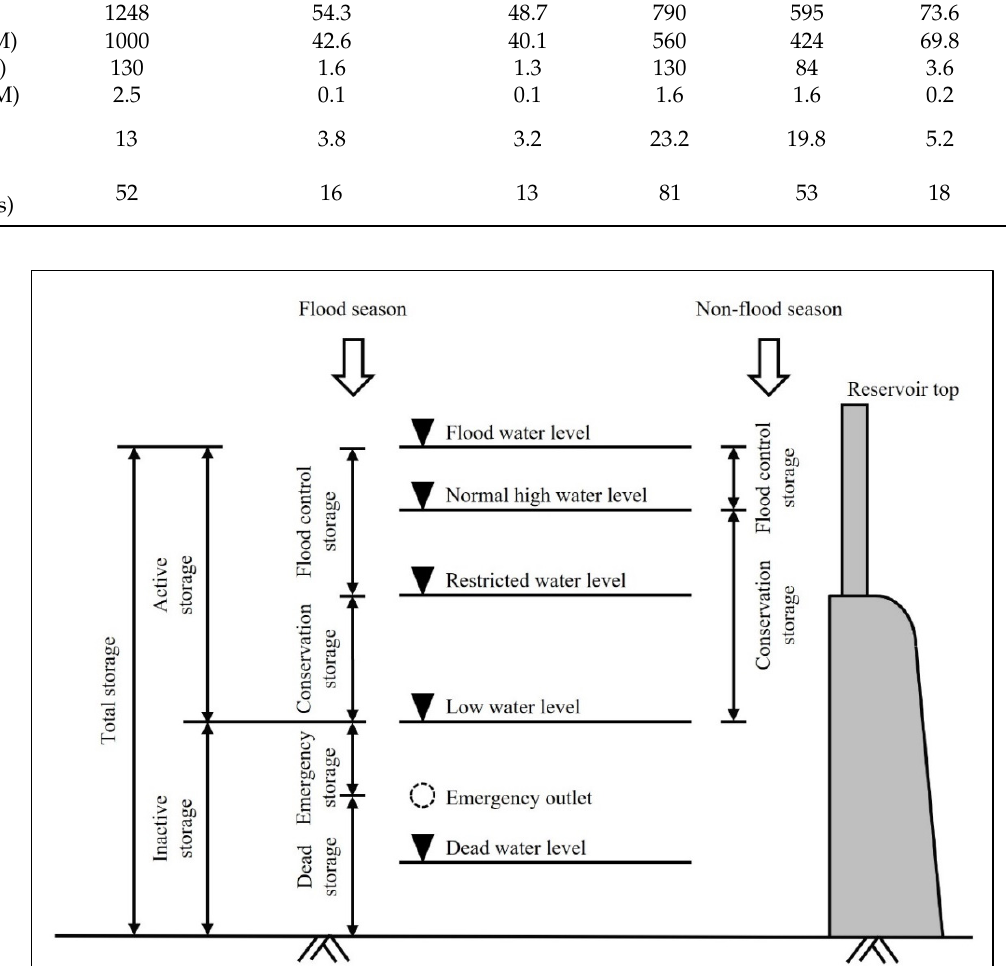
Figure 2. Description of multipurpose reservoir storage zones and water levels. The water